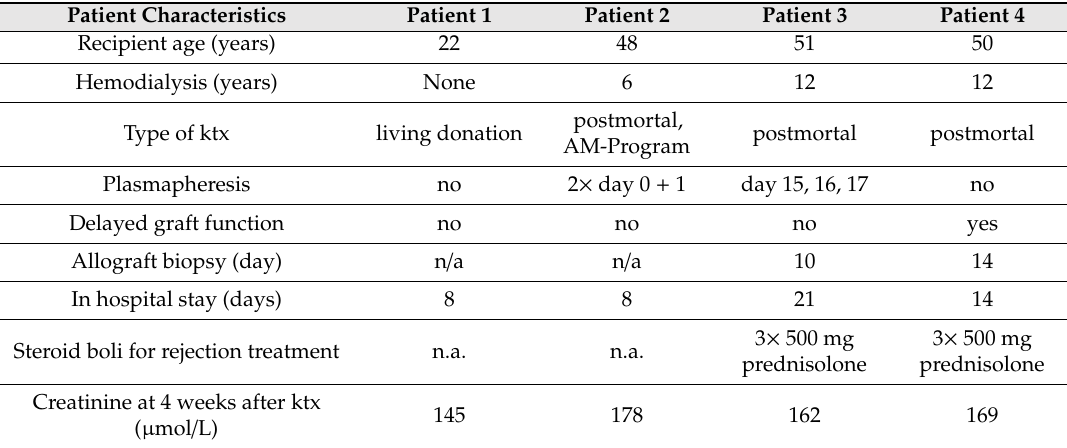
Table 2. Pilot study in the early phase after